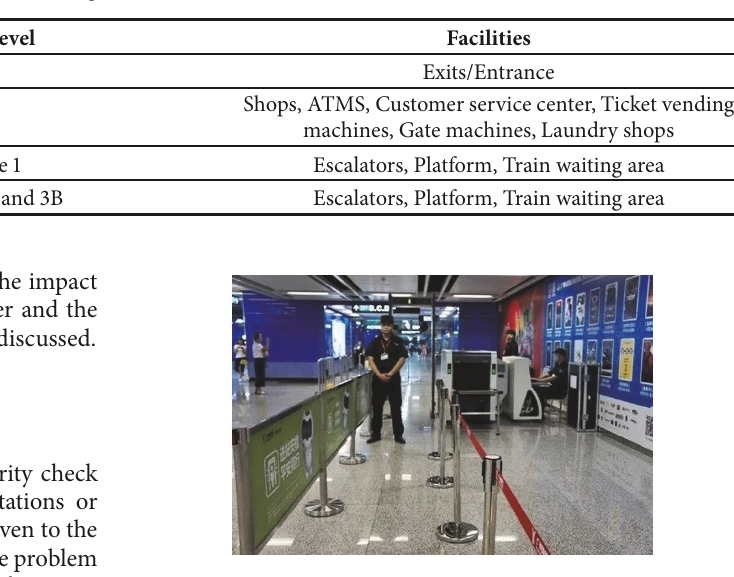
Figure 1: Typical security check in Guangzhou Metro (Luggage check on the right, passenger check on the